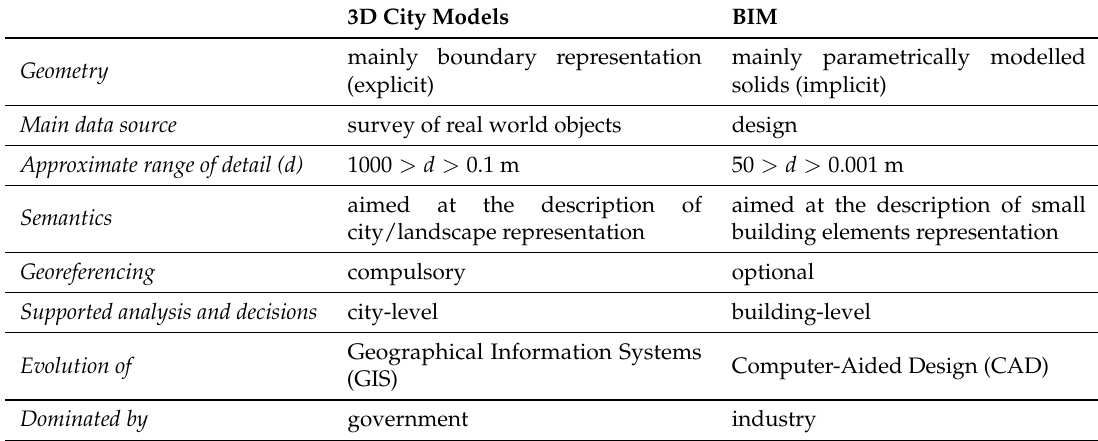
Table 1. Comparison between 3D city models features and Building Information Model (BIM)